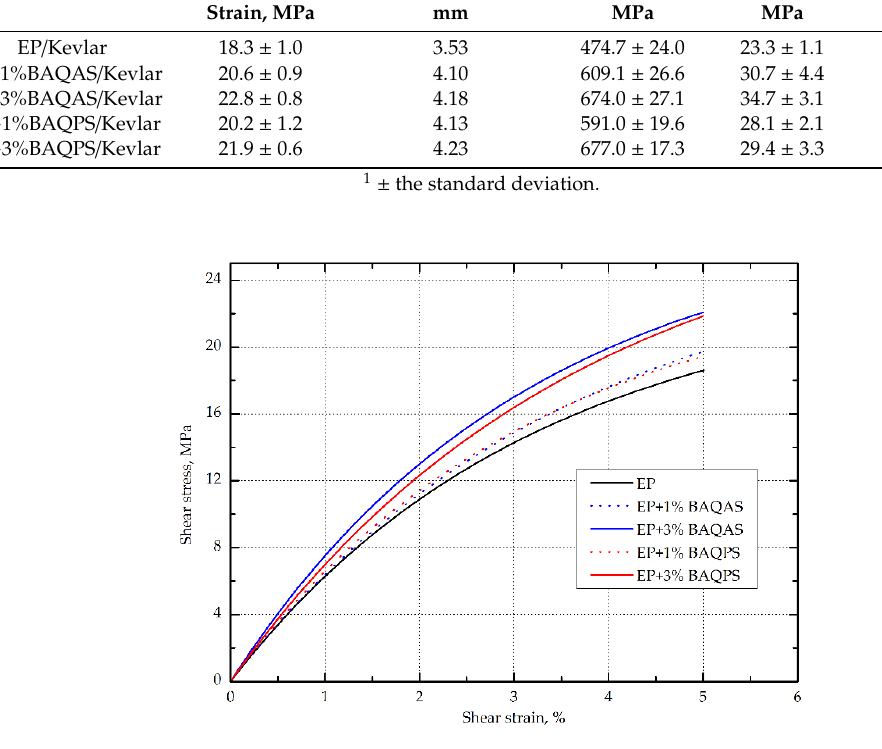
Figure 8. The shear load vs. shear displacement curves of Kevlar-reinforced laminates with EP and EP containing modified bentonite matrices.